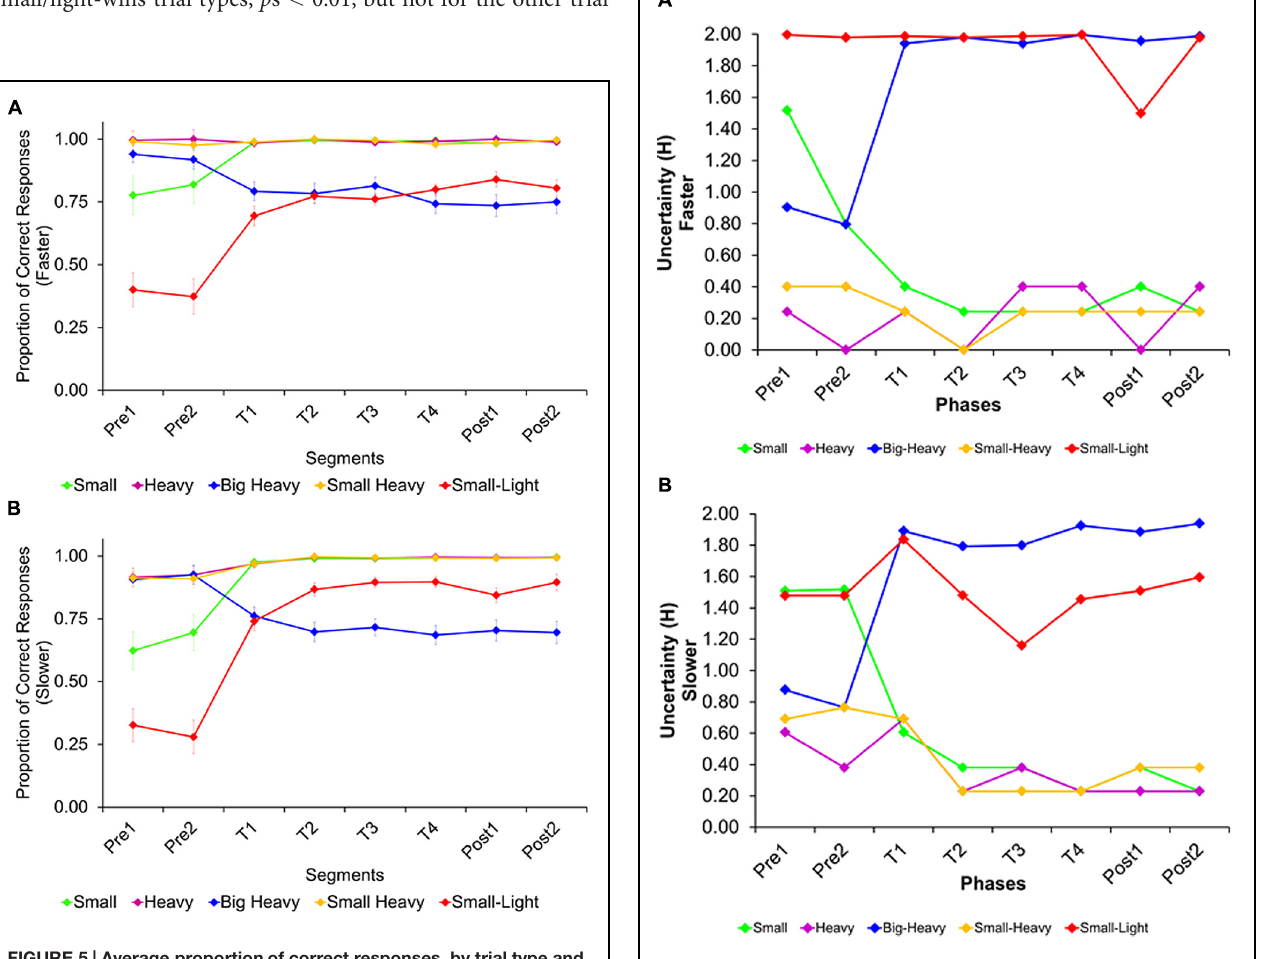
FIGURE 6 | Uncertainty H of each trial type, separated by segment and trial type, in the sink-faster (A) and the sink-slower condition